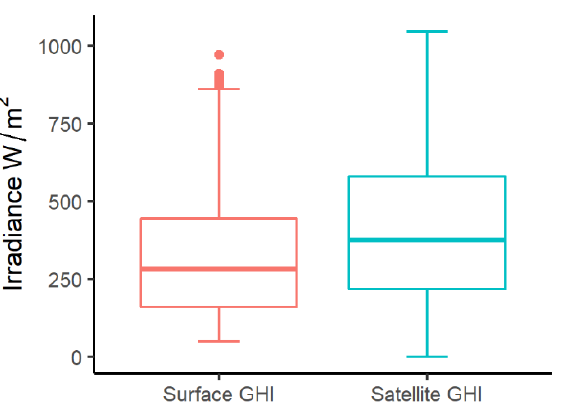
Figure 8. Boxplot comparison between surface and satellite GHI estimation [W m − 2 ].